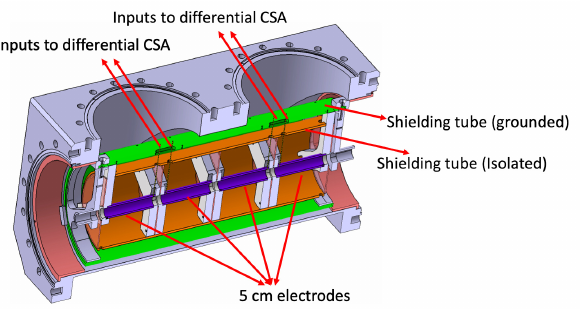
Figure 6. Cross section of the differential detector. The detector consists of two differential CSAs, which are not shown here.